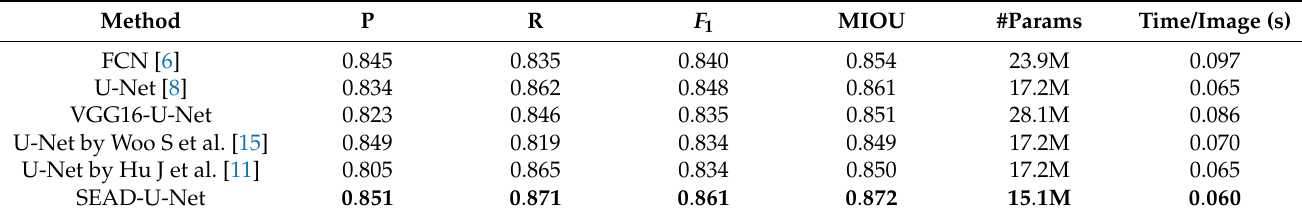
Table 3. Experimental results of segmentation on DeepCrack dataset.